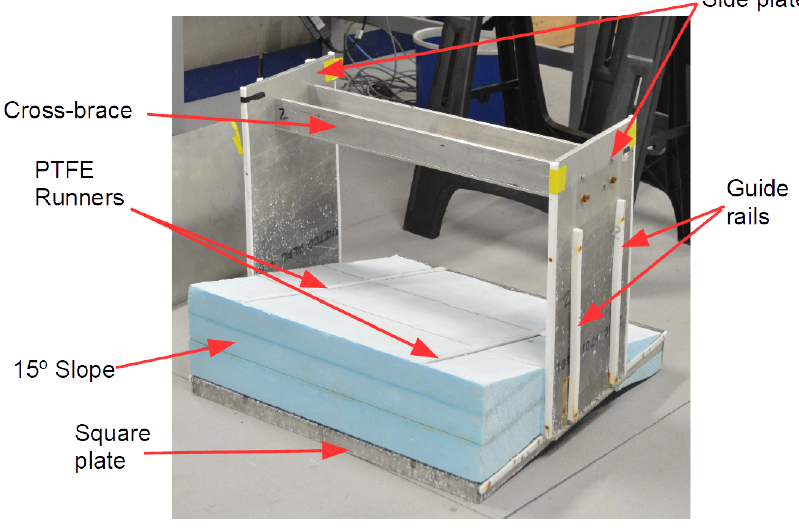
Figure 3. Photograph showing the fault rupture